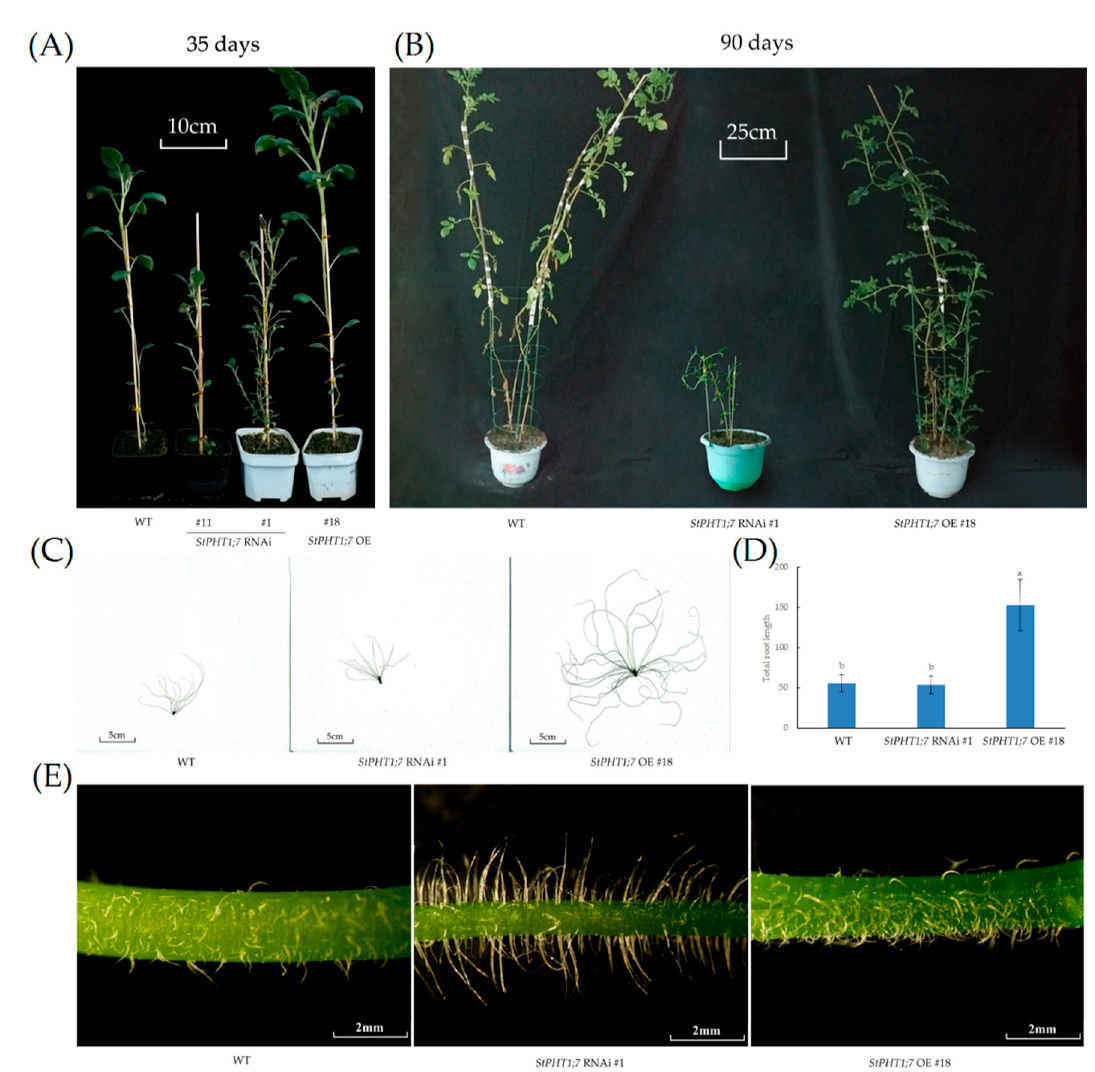
Figure 8. ( A ) Phenotype of negative control (WT), StPHT1;7 RNAi #1, StPHT1;7 RNAi #11, and